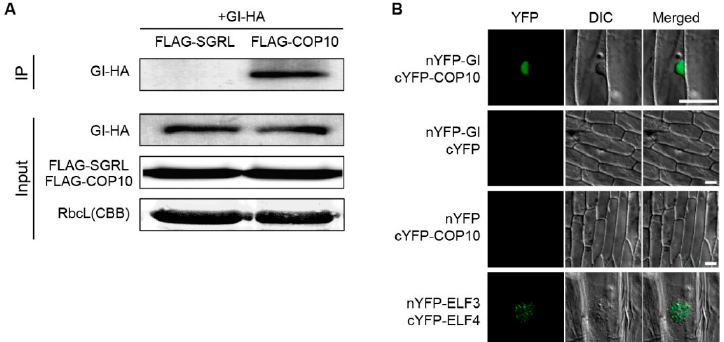
Figure 4. COP10 interacts with GI in plants. ( A ) Co-immunoprecipitation of COP10 and GI using 35S:FLAG-COP10 , 35S:HA-GI , and 35S:SGRL-FLAG . Total protein was extracted from two-week-old seedlings. FLAG-beads were used for pull-down. Anti-HA antibody was used for GI-HA protein band. 35S:SGRL-FLAG plants served as a negative control. The upper panel is co-immunoprecipitated GI-HA protein using an anti-HA antibody after an anti-FLAG-bead pull-down assay. As a loading control, RbcL protein levels were visualized by staining the immunoblot with Coomassie Brilliant Blue; ( B ) BiFC analysis of the interaction between COP10 and GI in the nucleus of an onion epidermal cell. nYFP-ELF3 and cYFP-ELF4 plasmids served as a positive control [21]. For the negative controls, empty nYFP-GI/cYFP and nYFP/cYFP-COP10 were used. Each pair of recombinant plasmids encoding nYFP and cYFP fusions was mixed 1:1 ( w / w ) and co-bombarded into onion epidermal cell layers. The transformed onion epidermal layers were incubated at 22 °C for 16–24 h under dark condition. YFP fluorescence was indicated by green color. Scale bar = 50 µ m. These experiments were repeated three times with the same results.